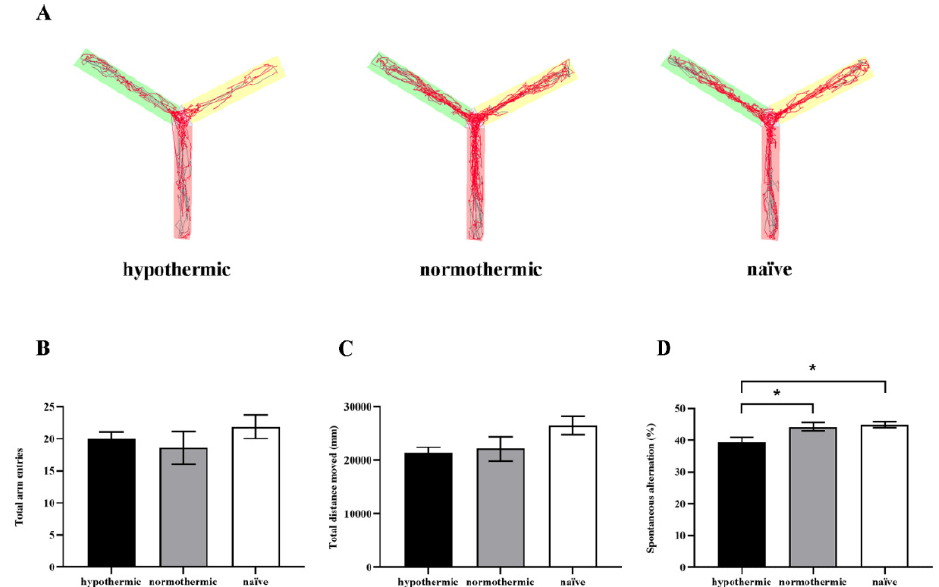
Figure 2. The effects of intraoperative hypothermia on the spatial working memory of rats measured by the Y-maze spontaneous alternation. ( A ) Representative mobile trajectories of rats among different groups; ( B ) the number of total arm entries of rats from different groups; ( C ) the total distance moved during 8 min free exploration in the Y-maze; ( D ) the spontaneous alternation percentage in different groups. Data are expressed as mean ± SEM. * p < 0.05, n =